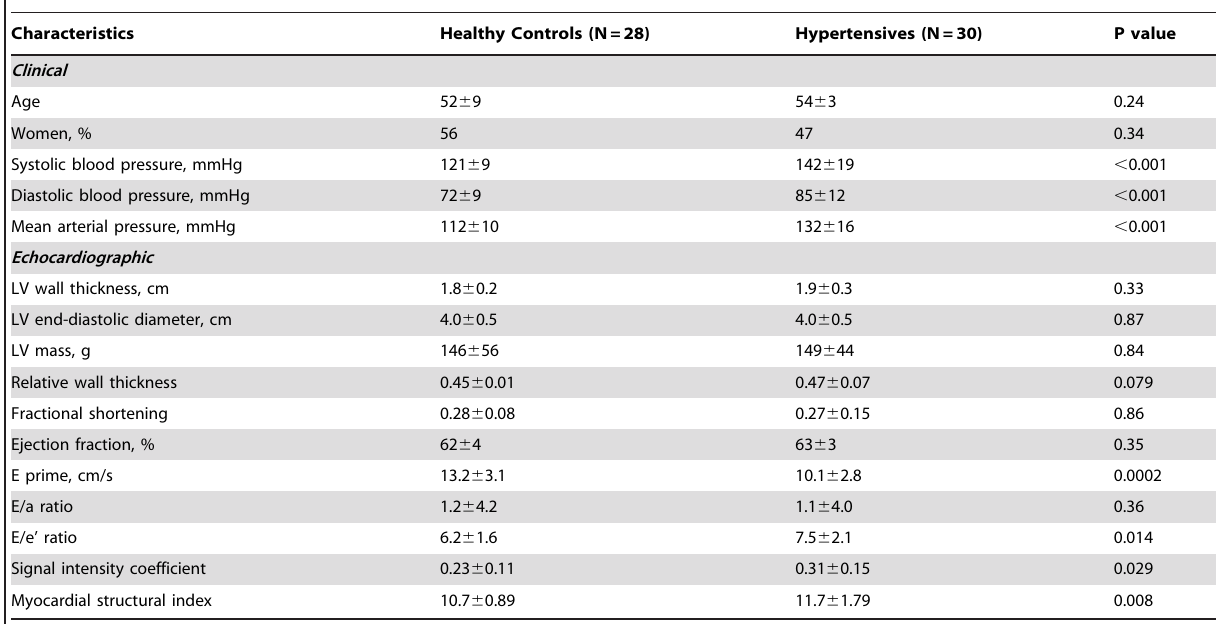
Table 1. Characteristics of the Clinical Study